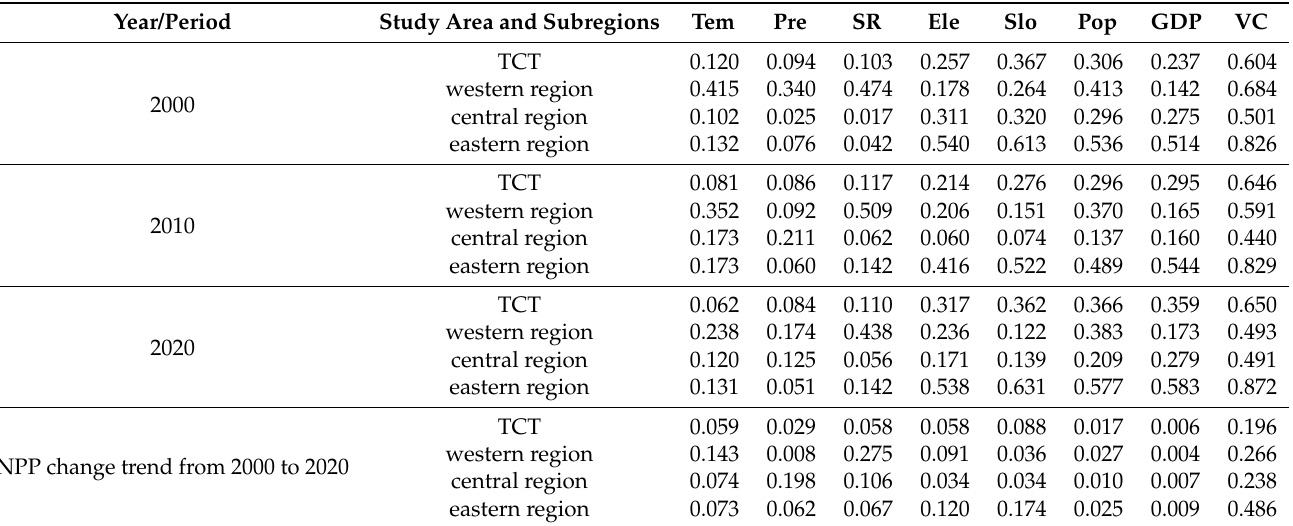
Table 2. Determinant power of eight factors on the spatial pattern of NPP in 2000, 2010, and 2020 and on the NPP change trend from 2000 to